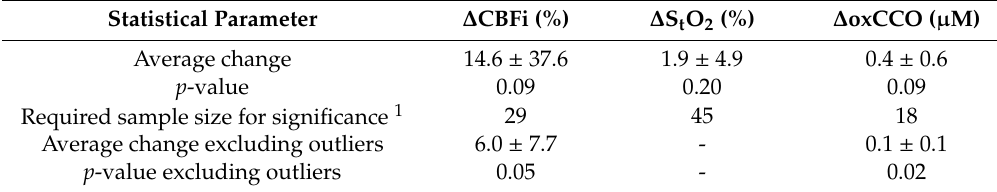
Figure 4. Boxplots showing changes in CBFi ( a ) and oxCCO ( c ) following ventricular tap and S t O 2 ( b ) before and after the tap. Results are based on the difference between pre- and post-VT measurements that were averaged over 2-min periods. Individual data points are displayed; outliers are indicated by the crosses on the borders and represent ∆ CBFi values of 122% and − 25% and ∆ oxCCO of 1.7 µ M. Table 2. Average changes following VT relative to baseline, t -test, and power analysis.